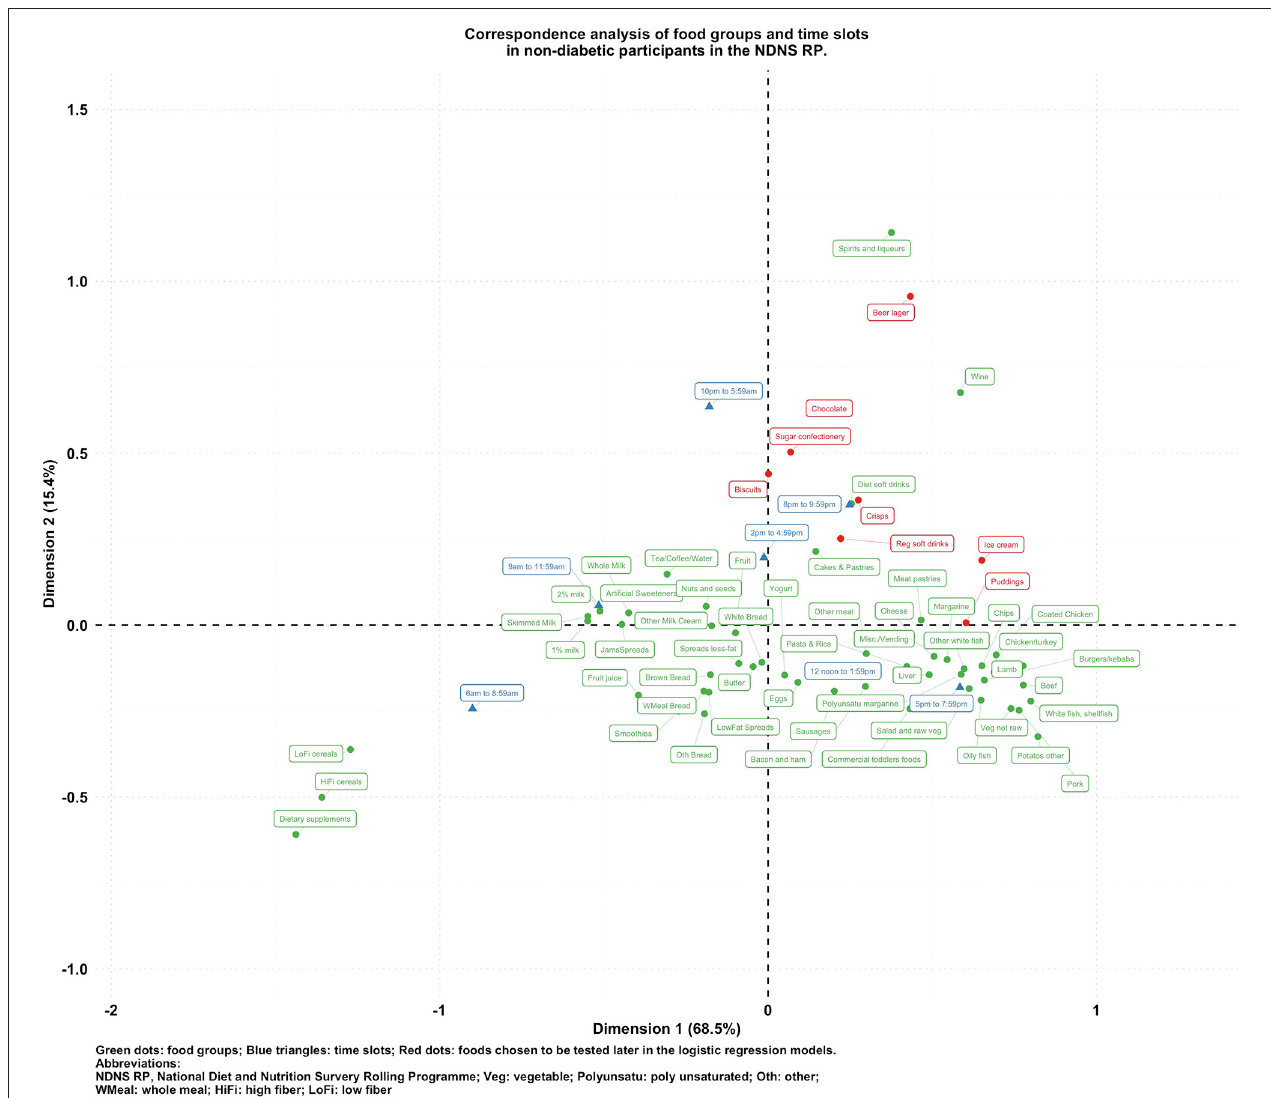
FIGURE 2 | Biplot of food groups and eating time slots in non-diabetic participants in the NDNS RP.